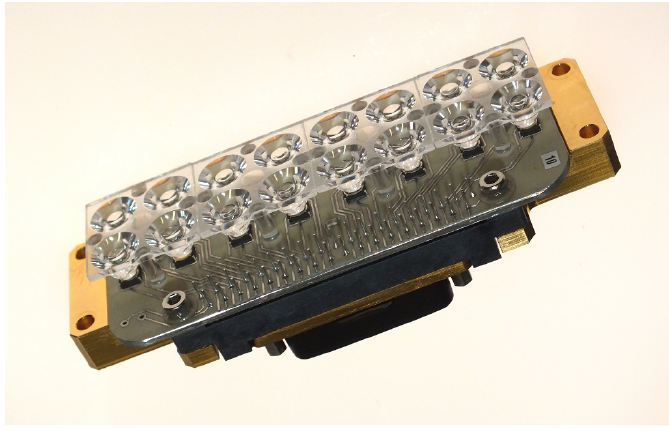
Figure 9. Calibration unit.